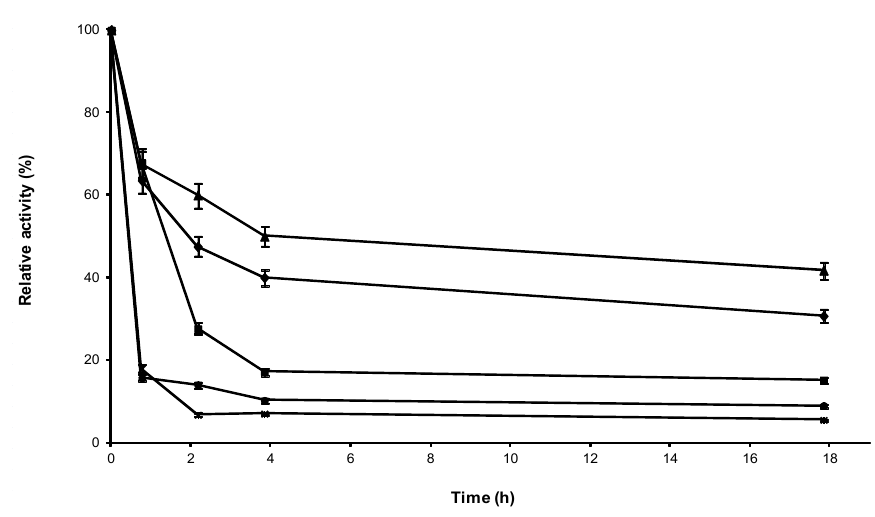
˝ C and pH 10. Without additive ( ˆ ),